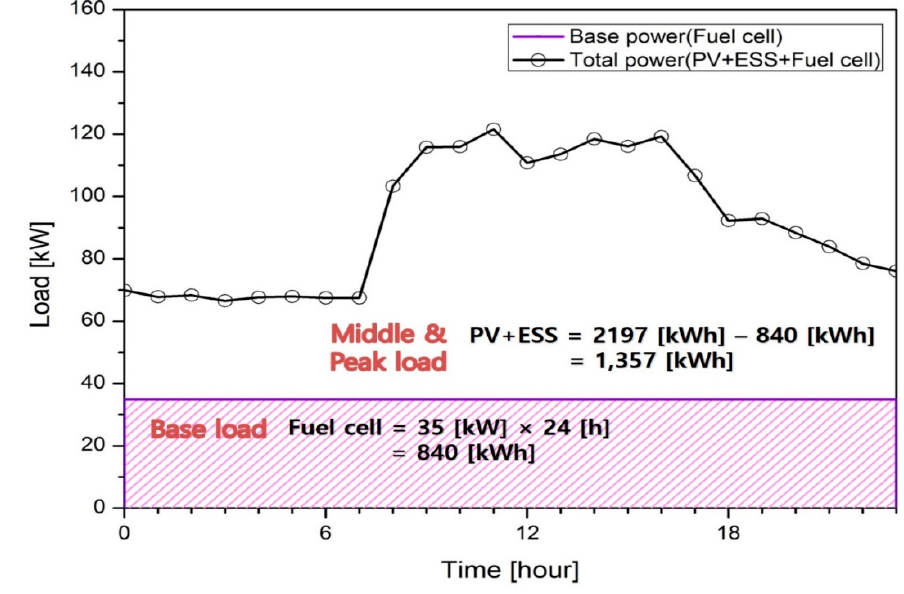
Figure 5. Portion of each generation source for the day loads.